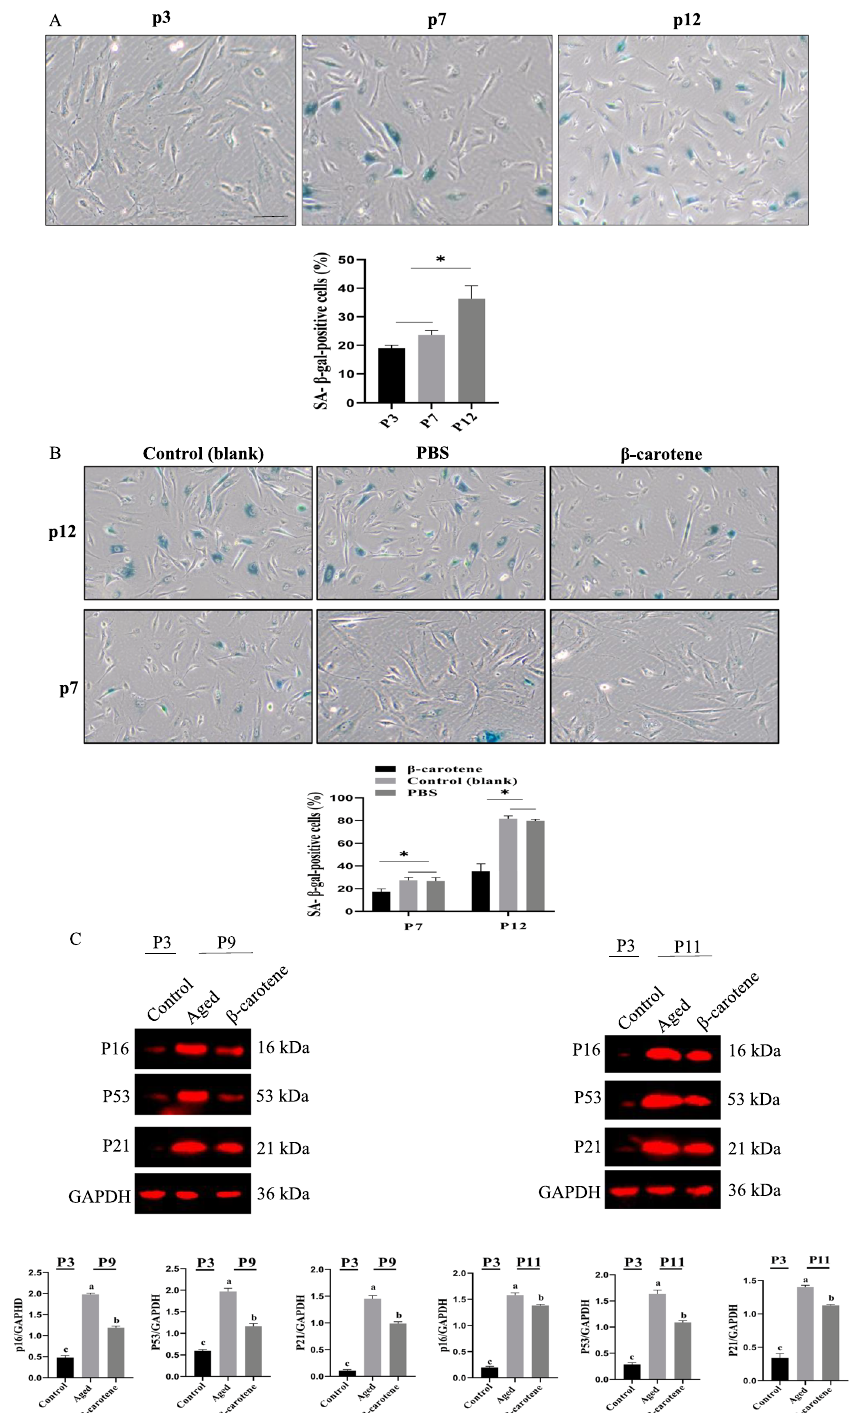
Fig. 6 The effect of β-carotene on replicative aging in Ad-MSCs. A Analysis of aging of MSCs upon serial passage. n 3 biological replicates. B The ratio of SA-β-gal-positive cells was down-regulated. n = replicates. C The expression level of p16, p53, and p21 was down-regulated by β-carotene treatment. D β-carotene treatment increased the clonal expansion ability of MSCs. E H3K9me3 expression was increased by β-carotene treatment. F β-carotene treatment up-regulated HP1α and